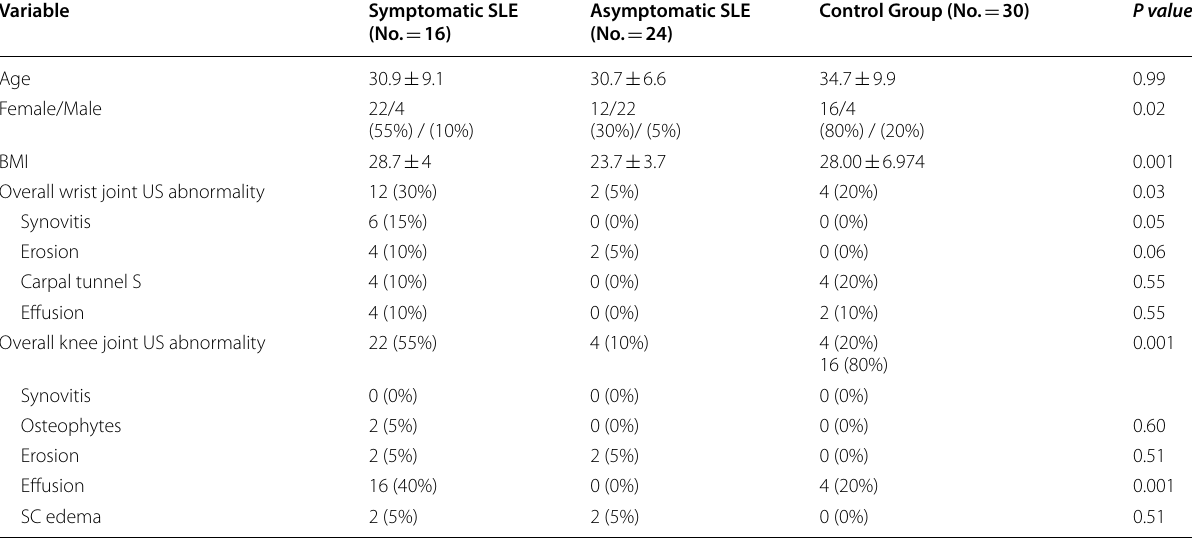
US ultrasound ; SC subcutaneous